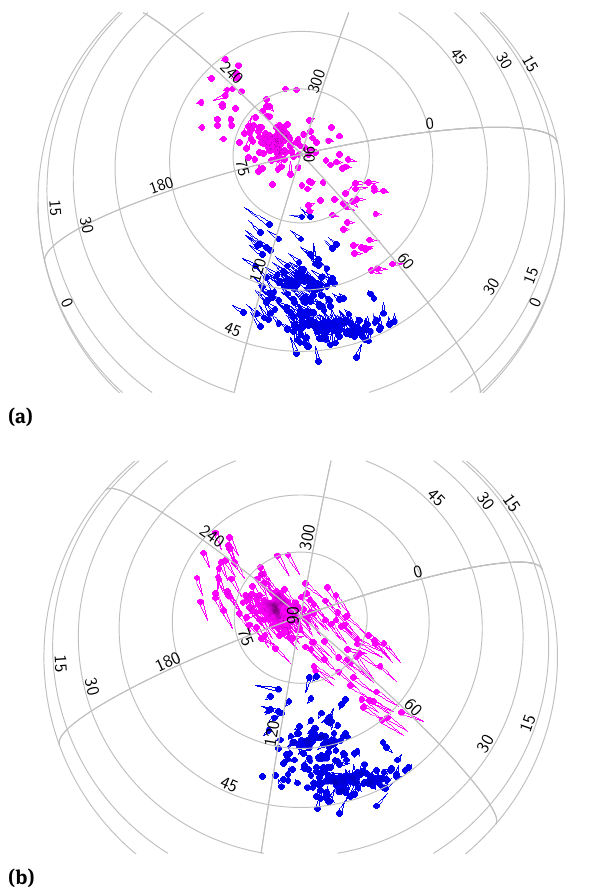
Figure 7. Residual tangential velocities of refined samples of stars referred to Coma Ber cluster (magenta dots) and to Group X (blue dots) in respect to the mean space motion of Coma Ber (upper panel) and Group X (lower panel). The length of an arrow in degrees (in scale of the figure) corresponds to the residual velocity in km/s. Coordinate frame is Galactic